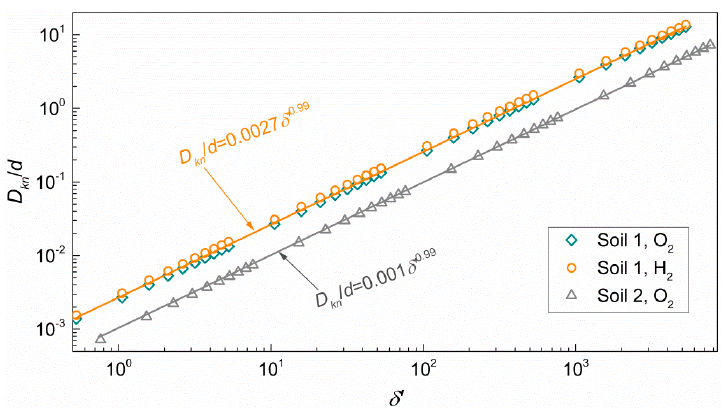
Figure 10. The comparison between the normalized effective Knudsen diffusion coefficients calculated from pore ‐ scale simulations with that estimated by Equation (7).